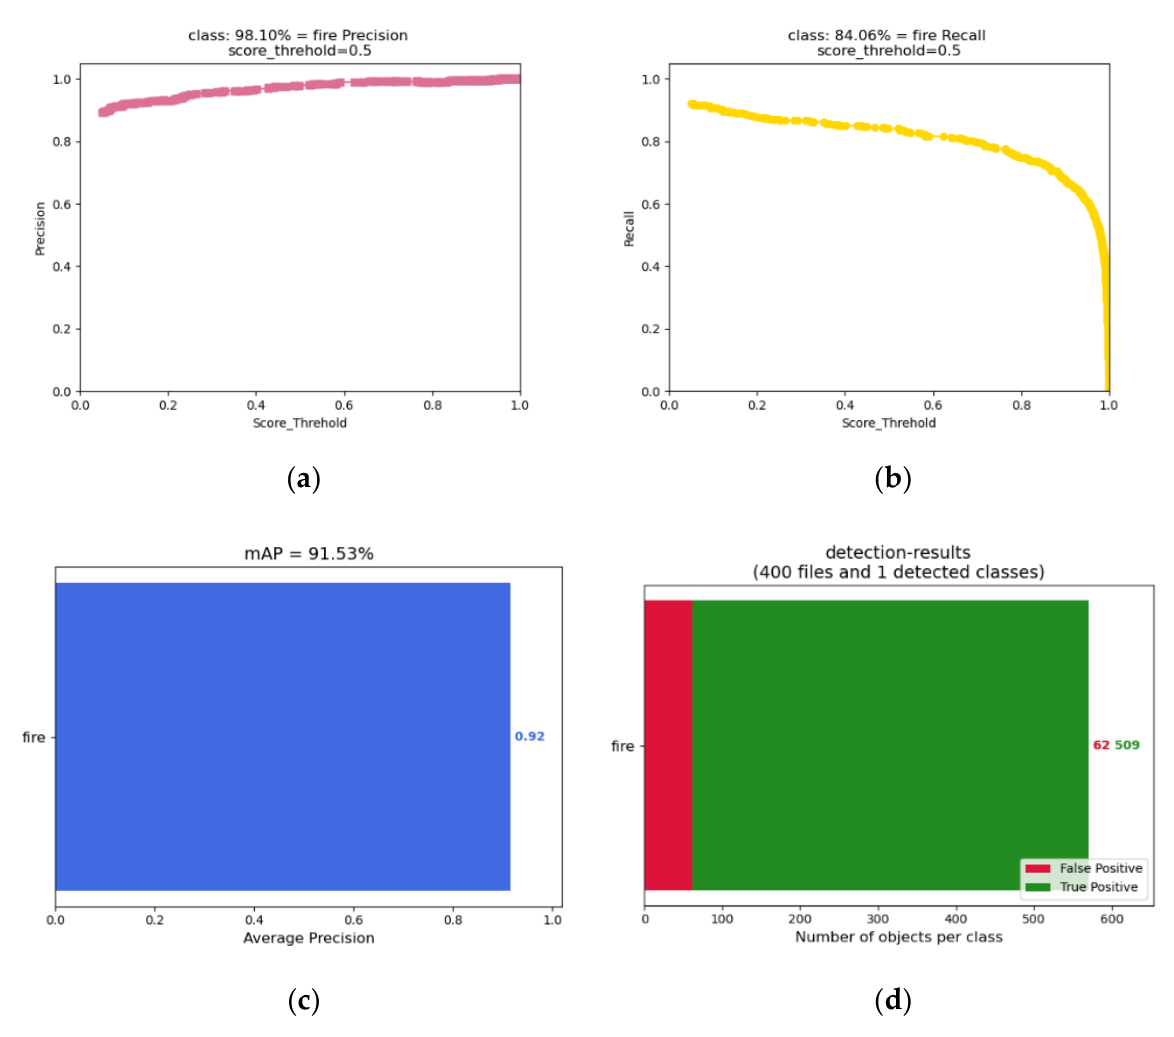
Figure 10. Graph depicting test results for 400 pictures. ( a ) Precision; ( b ) Recall; ( c ) mAP; ( d ) Detection-results.